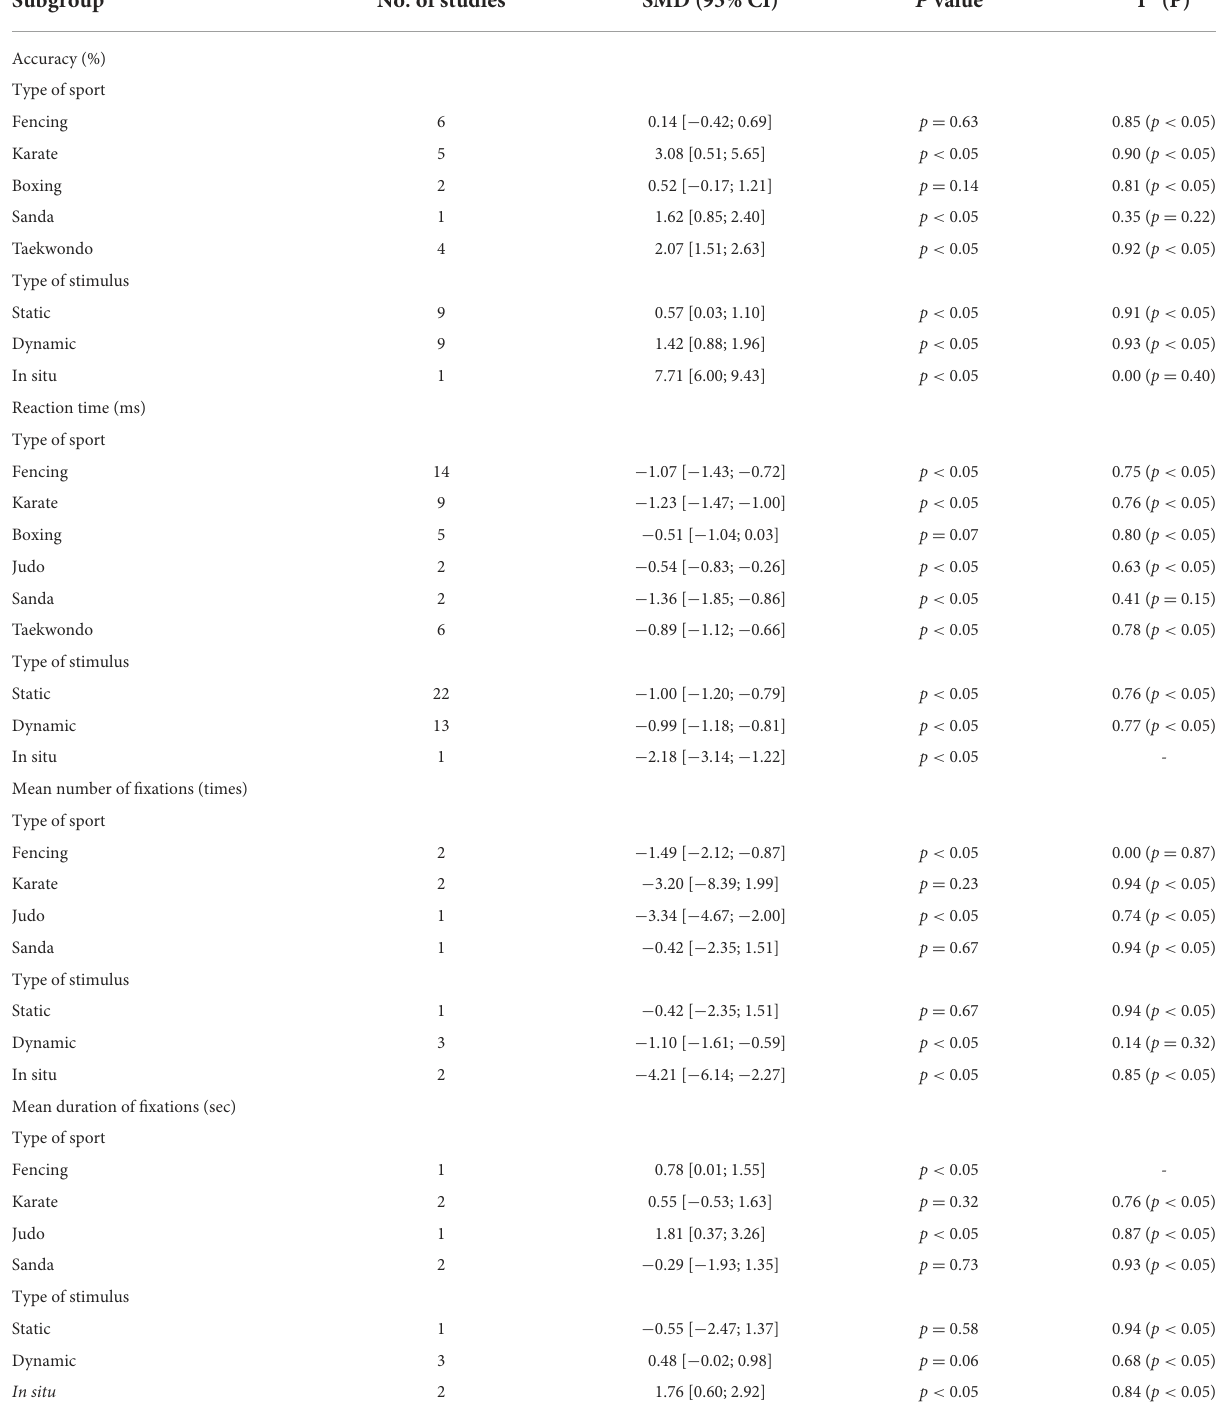
TABLE 2 Subgroup analyses of standardized mean differences between the expert and non-expert groups by type of sport and stimulus presentation. Subgroup No. of